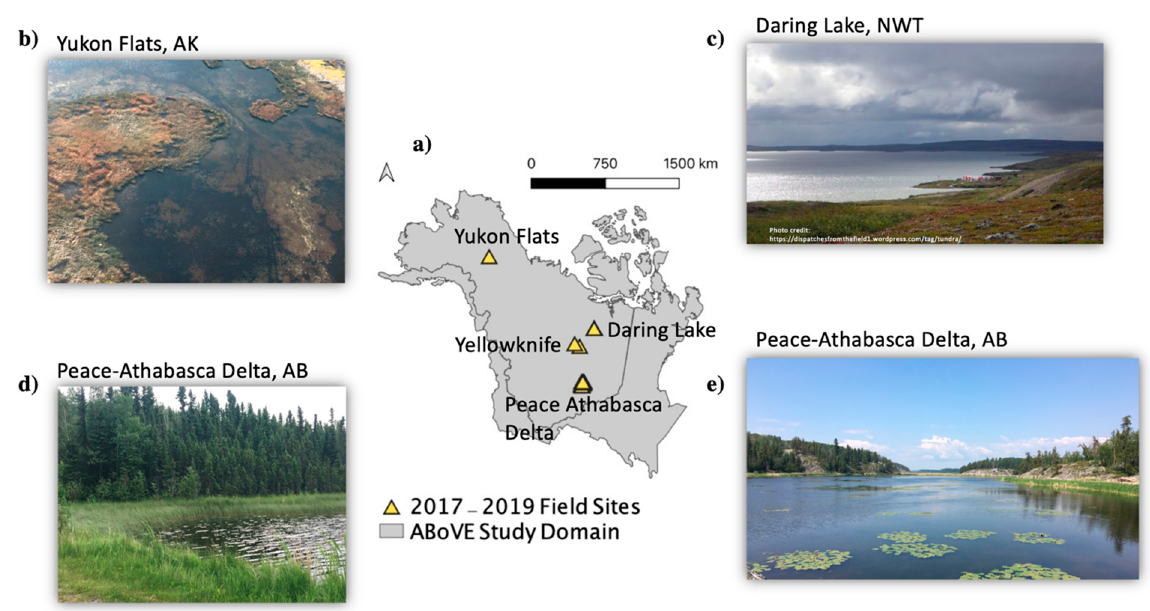
Figure 1. Study sites across ( a ) arctic-boreal northwestern North America including ( b ) sub-arctic Yukon Flats, Alaska, USA ( c ) tundra Daring Lake, Northwest Territories, Canada, ( d ) a boreal lake in the Peace-Athabasca Delta, Alberta, Canada, and ( e ) a shield lake with rocky shorelines in the Peace-Athabasca Delta, Alberta, Canada